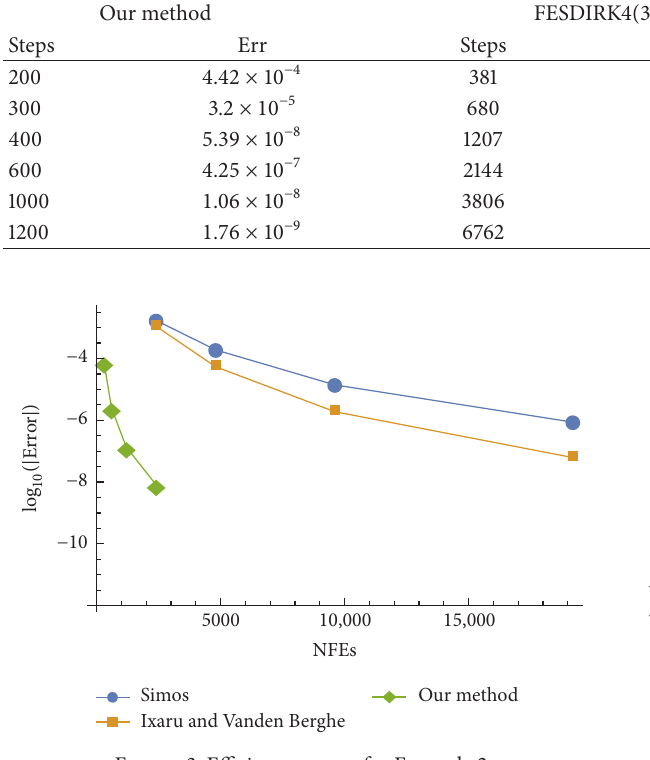
Figure 3: Efficiency curves for Example